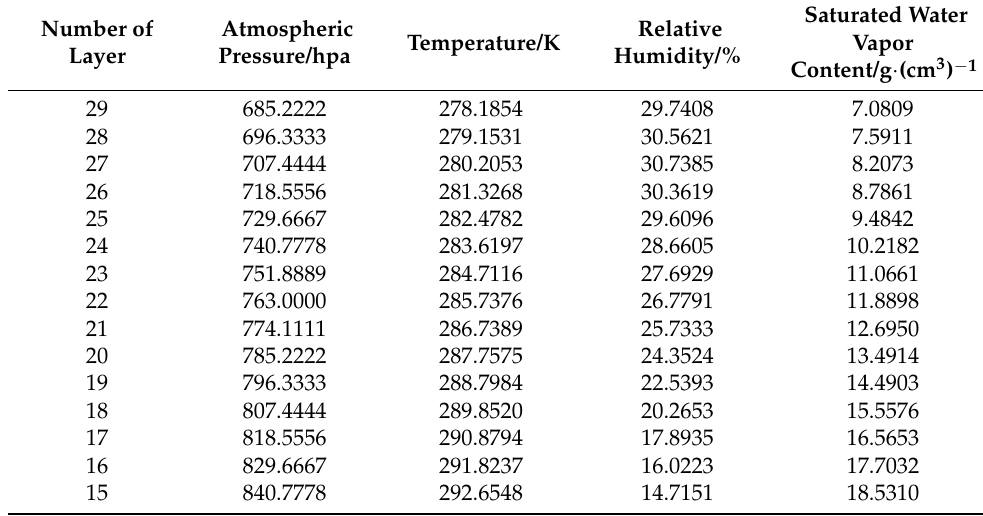
Table 3. Atmospheric parameters of each